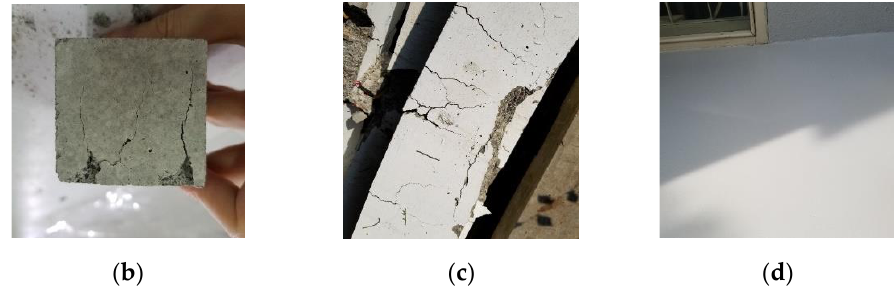
Figure 3. ( a ) Dataset from cylindrical concrete specimen; ( b ) dataset from mortar specimen; ( c ) dataset from beam specimen; ( d ) dataset from concrete wall.